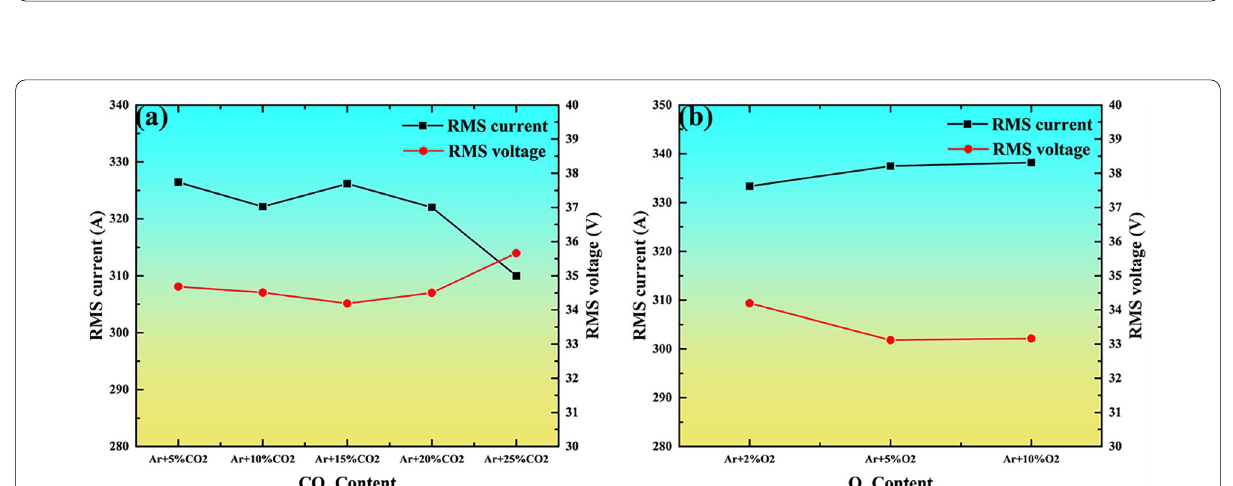
2% O 2 ; b Ar 5% O 2 ; c Ar 10% O 2 + + +